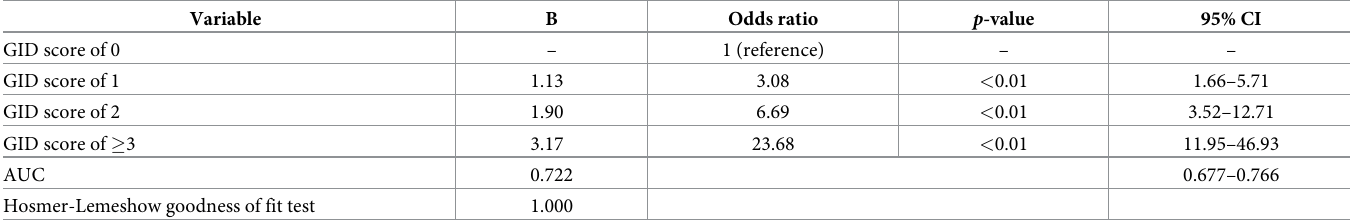
Table 2. Logistic regression analysis, AUC, and Hosmer–Lemeshow goodness of fit test for validating the accuracy of GID score in older patients with influenza in ED. Variable